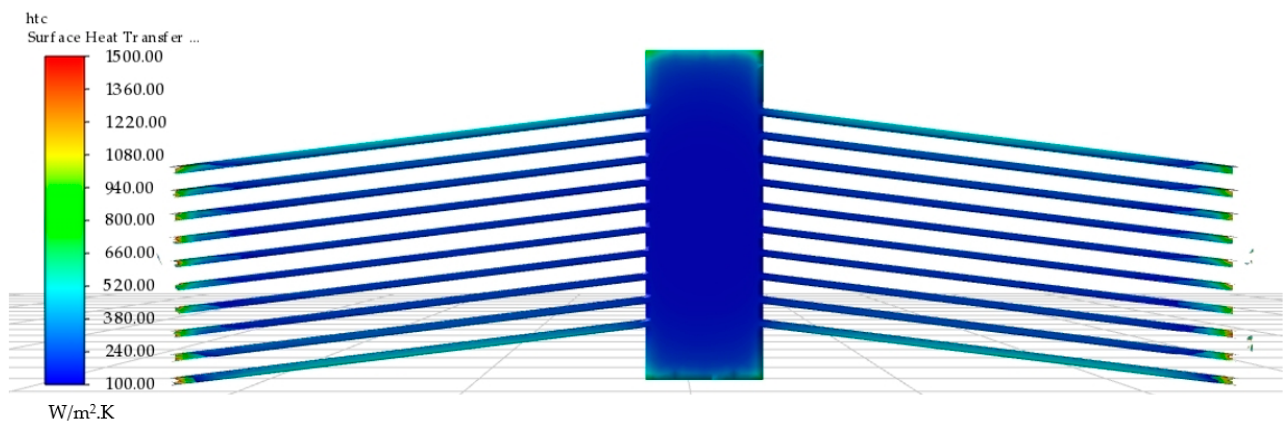
Figure 12. Finite volume numerical evaluation of spatial heat transfer coefficient at the fluid–structure interface. Results displayed are for an applied potential of 4 V. Note that the values in the legend are given in W/m 2 ·K, which is equivalent to pW/µm 2 ·K.